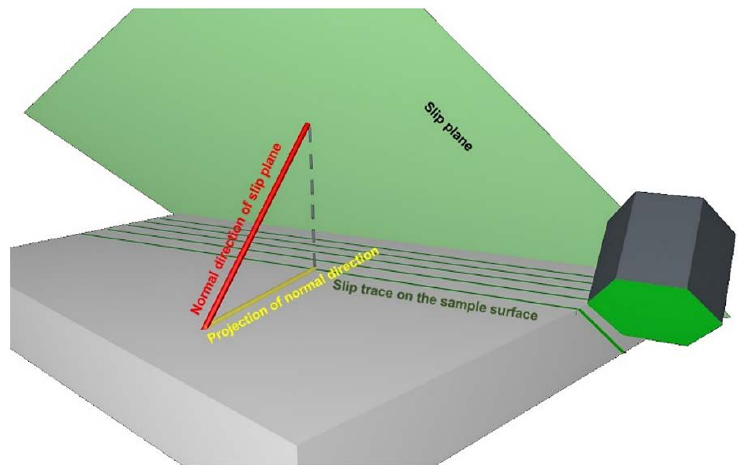
Figure 3. Schematic diagram showing the relationship among the slip plane, normal direction of slip plane, projection of the normal direction, and slip trace on the sample. The projection of normal direction on the sample surface has a perpendicular relationship with the slip trace.